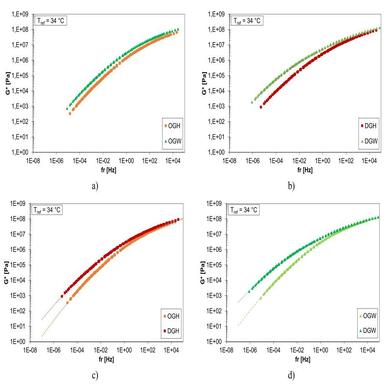
Comparisons between master curves elaborated from frequency sweep tests: a), OGH vs. OGW b) DGH vs. DGW extension, c) OGH vs. DGH and d) OGW vs. DGW.